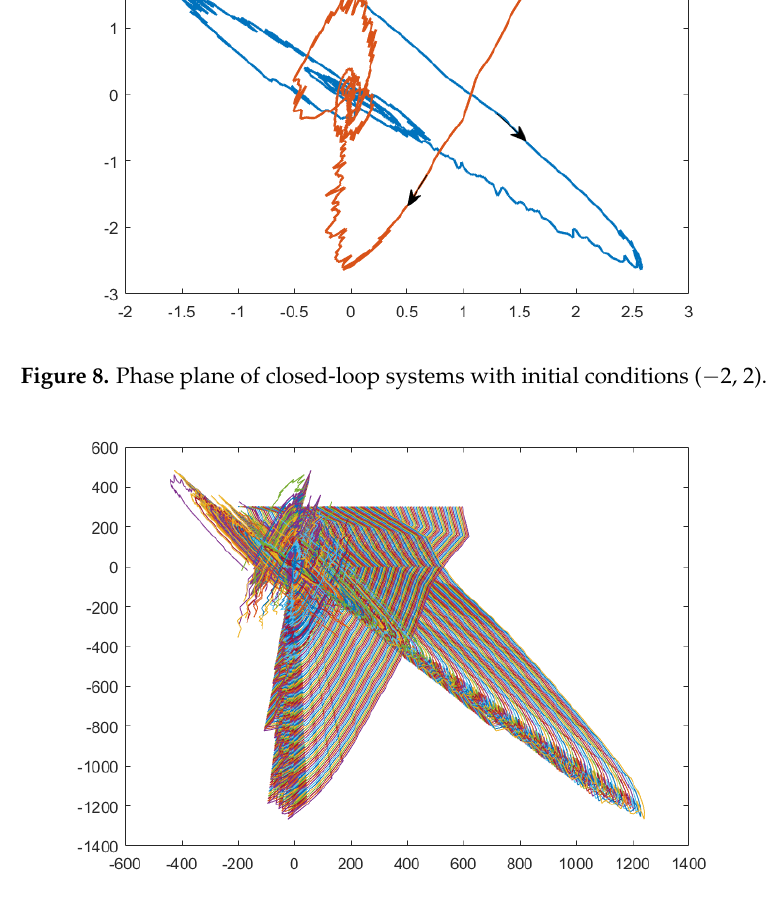
Figure 9. Phase plane of closed-loop systems with 100 different initial conditions ( x 1 ∈ [ − 200,200 ] , x 2 ∈ [ − 200,200 ] ).